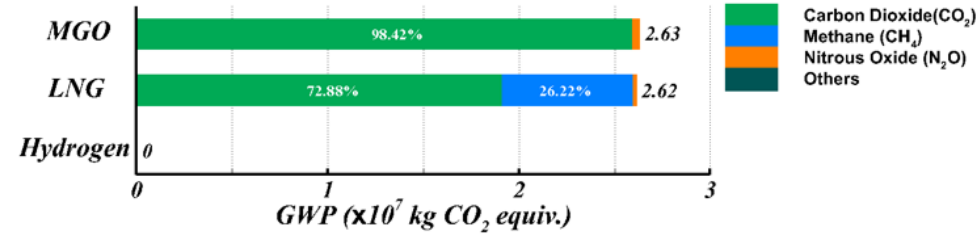
Figure 17. GWP results in the tank-to-wake phase.